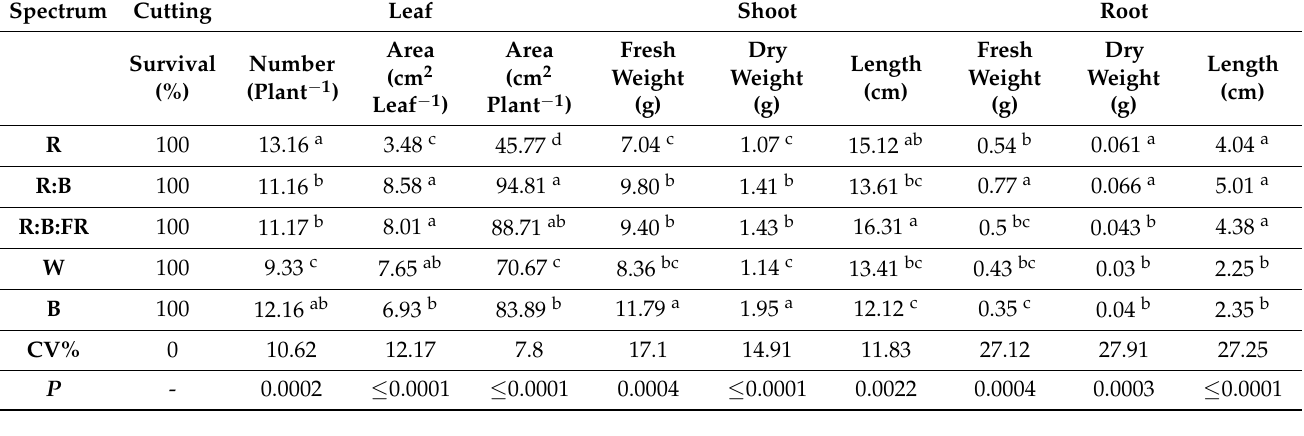
Table 1. Growth and morphology of chrysanthemum cuttings exposed for 30 days to different light quality regimes (red (R), red and blue (R:B), red, blue and far-red (R:B:FR), white (W) and blue (B); see the spectrum in Figure 9). During the experiment, the photosynthetic photon flux density was set to 150 ± 5 µ mol m − 2 s − 1 . Six replicates per treatment were assessed. Means within a column followed by the same letters are not significantly different at p ≤ 0.05, according to Duncan’s multiple range tests. CV % indicates the percentages of coefficient of variation among the treatments.